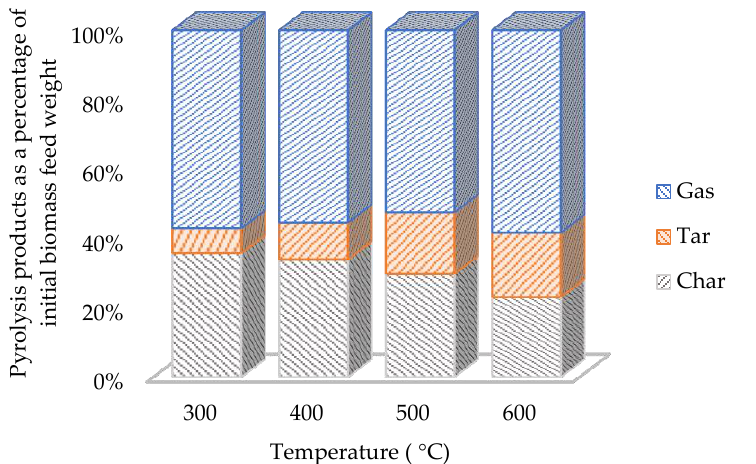
Figure 4. Distribution of the products generated during pyrolysis at different temperatures. Each test was performed in duplicate.